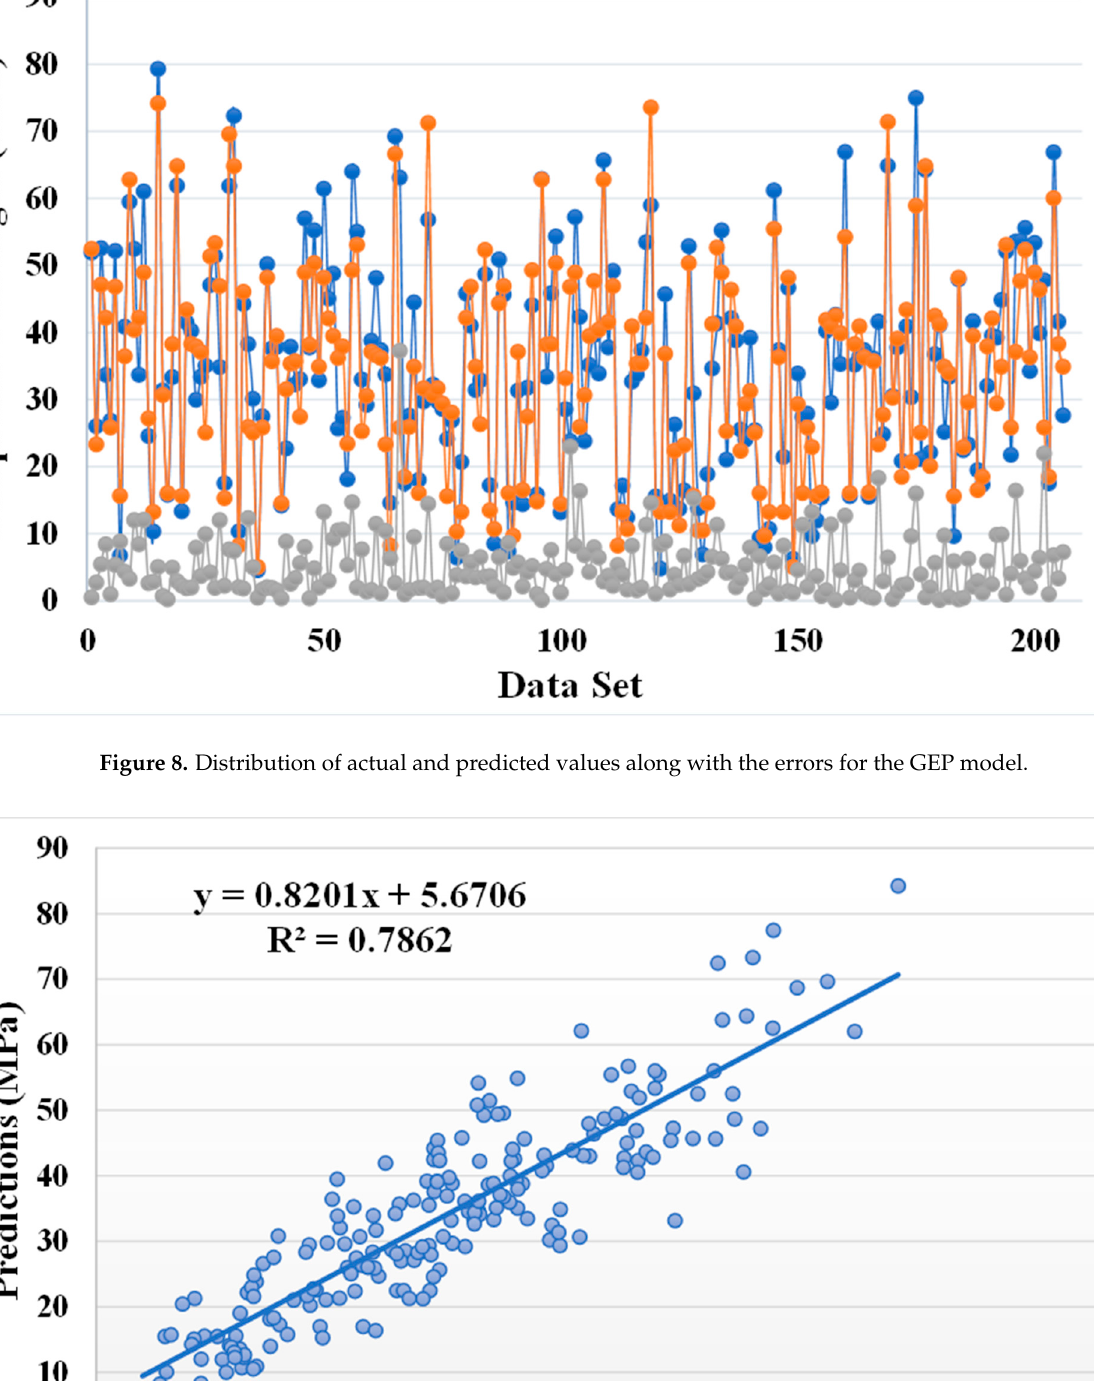
Figure 7. Relationship between the actual and predicted results of the GEP model.